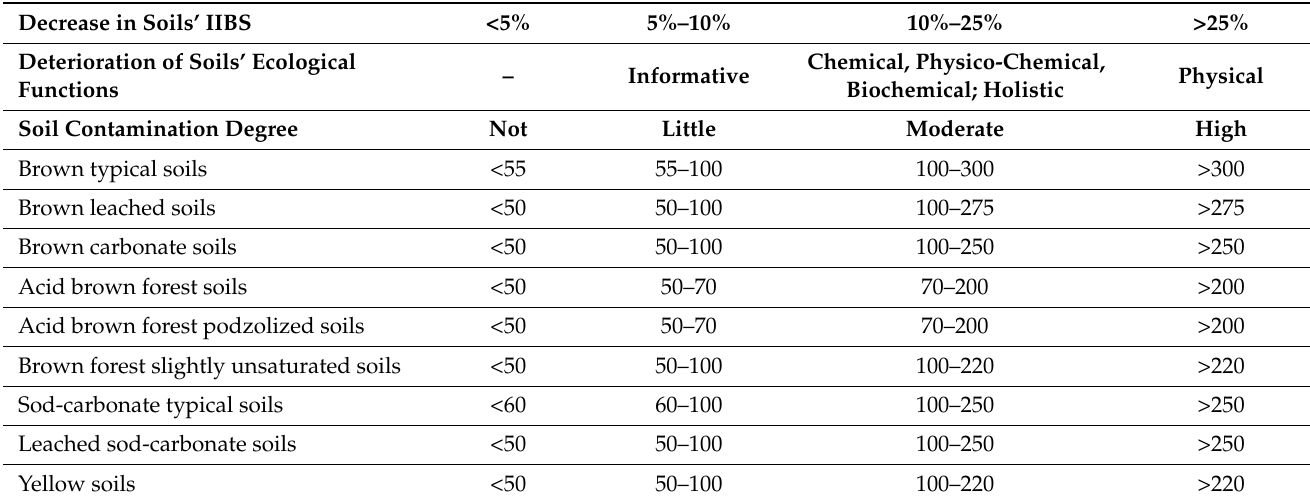
Table 3. Ecological normalization of the content of Cu in soils of the wet and dry subtropics according to Kolesnikov et al. [21],